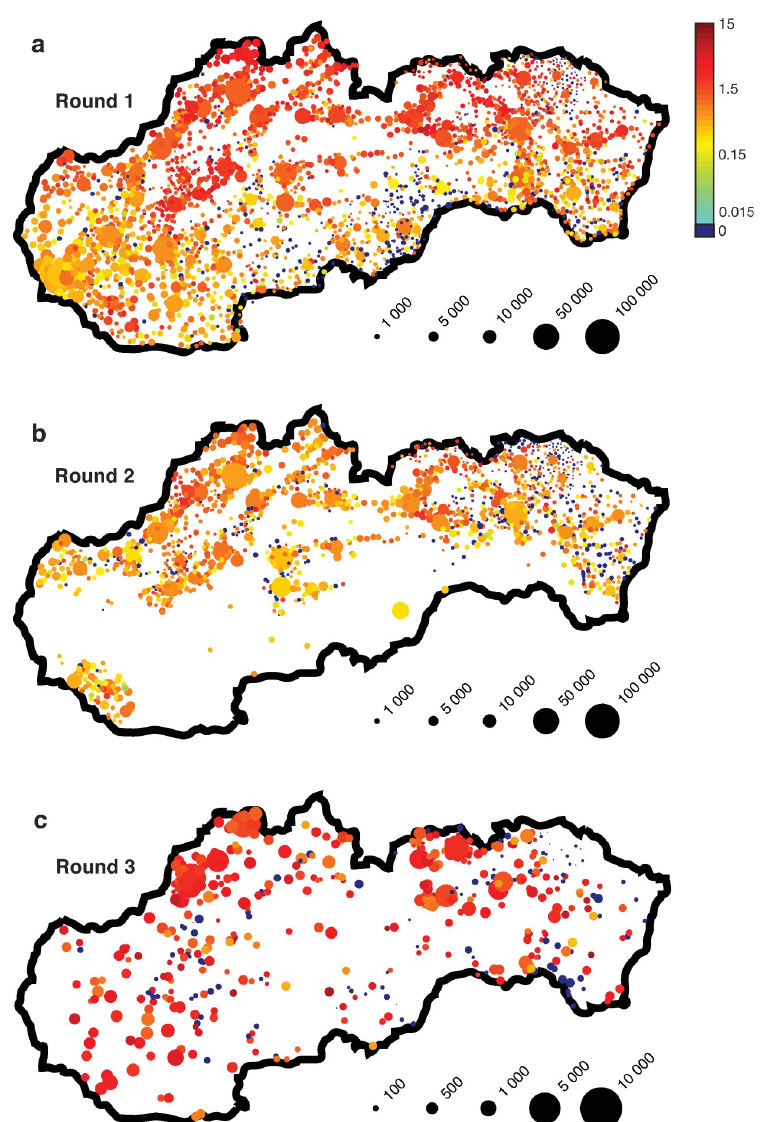
Fig 1. a-c Results of mass antigen testing in Rounds 1–3. Test positivity (%) for individual municipalities is encoded by a logarithmic color scale. Marker size indicates the total number of tests administered. Due to a lower number of tests in Round 3, marker size is proportionally increased for better data visibility. See S1 Code and dataset for data and code used to generate the figures. Nonlinear regression identifies relationships within the dataset and assesses their signifi- cance level. We used the standard notation for the p-values: � , �� , ��� mean p-value less than 0.1, 0.01, and 0.001, respectively. Data were fitted with built-in tools for nonlinear regression (nlinfit and nlparci) and a Curve Fitting Toolbox for weighted linear regression in MATLAB © . The data and the codes generating the figures can be found in S1 Code and dataset.